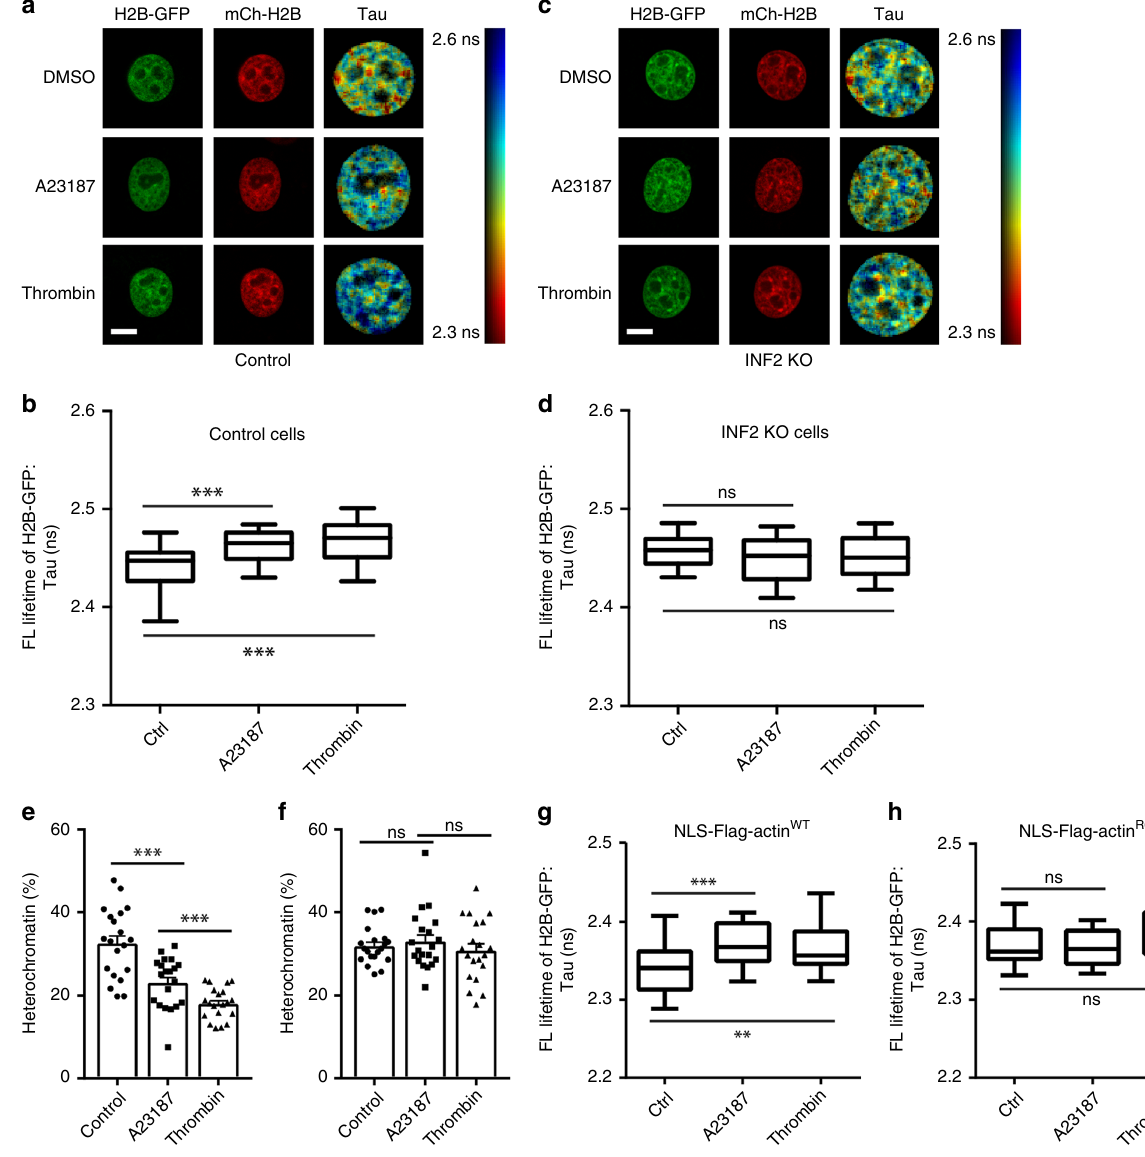
Fig. 5 INF2 and nuclear F-actin are required for chromatin dynamics. a , c Representative images and fl uorescence lifetime maps of control and INF2 KO cells expressing H2B-GFP and mCherry-H2B, where the ruler on the right depict GFP fl uorescence lifetime. Cells were treated with DMSO, A23817, or thrombin for 15 min, before being fi xed. Scale bars: 10 μ m. b , d Control and INF2 KO cells expressing H2B-GFP and mCherry-H2B were measured for GFP fl uorescence lifetime. Cells were treated with DMSO, A23187, or thrombin for 15 min. Thirty cells were measured for each condition. Boxes extend from the 25th to 75th percentiles. Middle line indicates median. Whiskers represent min to max with all points shown. One-way ANOVA test, *** p ≤ 0.001. e , f Cryopreserved cells were quanti fi ed for condensed chromatin based on EM images. n = 20 cells. One-way ANOVA test, *** p ≤ 0.001. Error bars: + s.e. m. g , h FLIM analyses of Flag-NLS-actin WT and Flag-NLS-actin-R62D cell nucleus showing chromatin reorganization after A23187 or thrombin. n = 30 cells for each condition. Boxes extend from the 25th to 75th percentiles. Middle line indicates median. Whiskers represent min to max with all points shown. One-way ANOVA test, ** p ≤ 0.01, *** p ≤ 0.001. Source data are provided as a Source Data fi